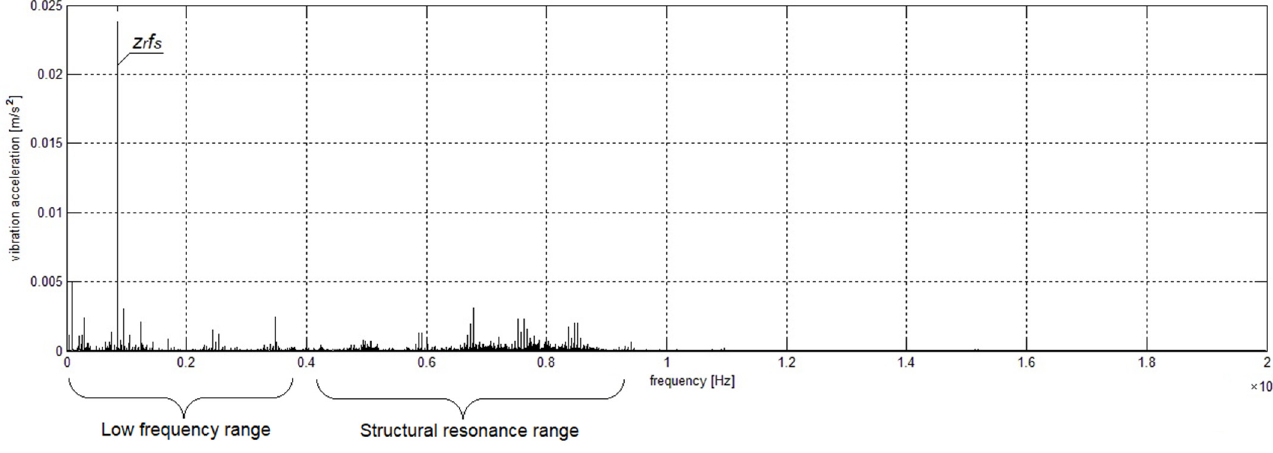
Figure 1. Frequency spectrum of vibration acceleration of the outer casing of a healthy motor. The dominant frequency component of vibrations is marked.